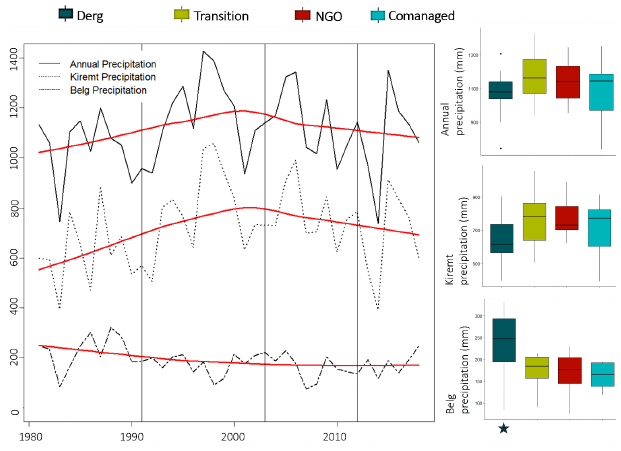
Fig. 7 . Trends in kiremt season (~1 July – 30 September), belg season (~1 Feb – 30 April), and total annual precipitation. Red lines indicate a lowess smoothing function applied across the entire time series. Vertical lines indicate the four periods of political and management change. Box plots illustrate differences in median and range of precipitation across those four periods. The star indicates a significantly higher belg season precipitation during the Derg